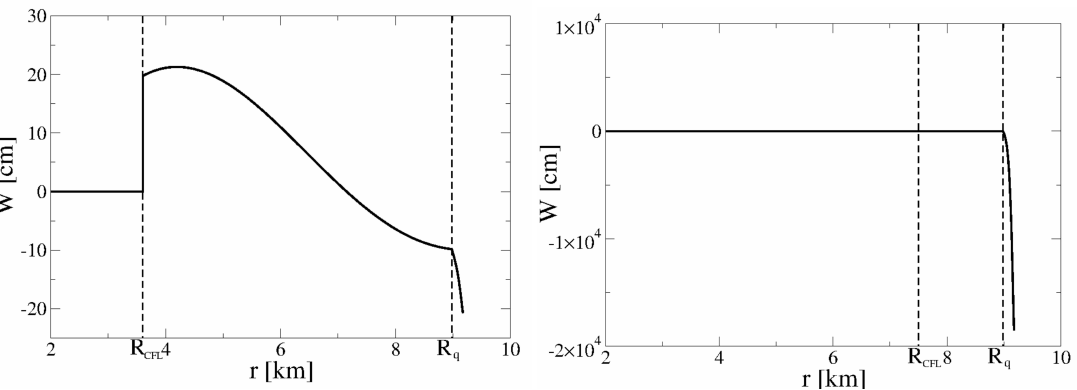
Figure 3. Radial dependence of the amplitude of the 1 t 1 mode oscillation inside our strange star model. Left : Oscillation of the coupled crusts oscillation (CCSO)-type (see text) obtained choosing a = 0.8. The amplitude of the oscillation is of the order of 20 cm. Right : Oscillation of the ISO-type (see text) obtained choosing a = 0.4. In the nuclear crust the amplitude can reach values of the order of few km